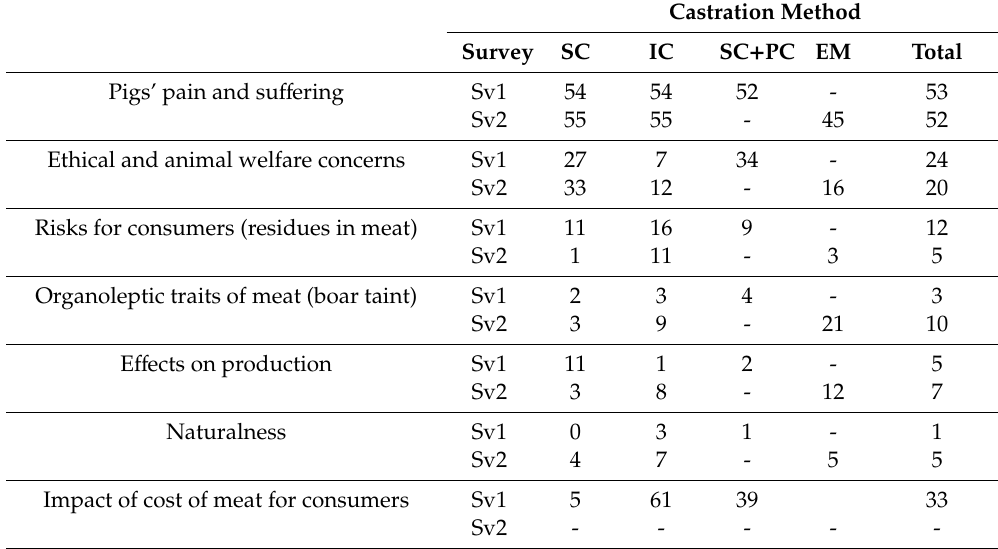
Table 3. Emerging themes (%) in the justification for attitudes towards di ff erent methods to deal with boar taint in pigs (Sv1, n = 441; Sv2, n = 768). SC = surgical castration without pain